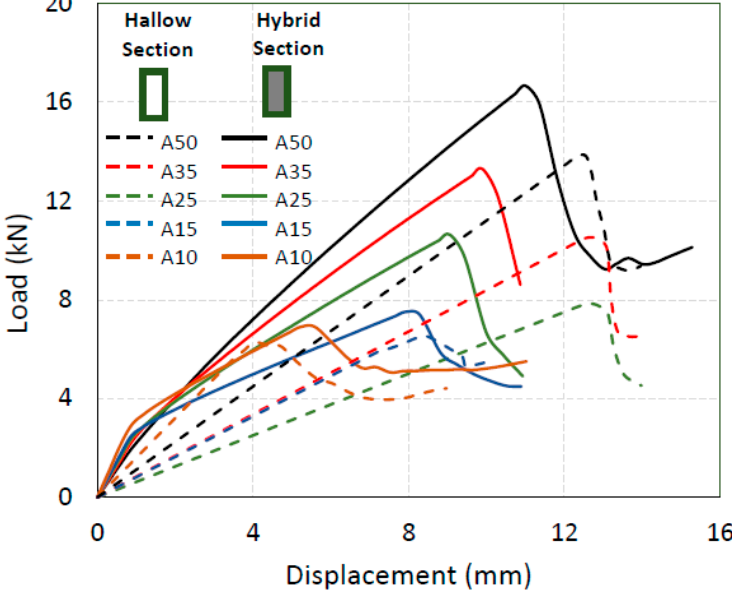
Figure 6. Load-deflection plot of areal change in rectangular beams.